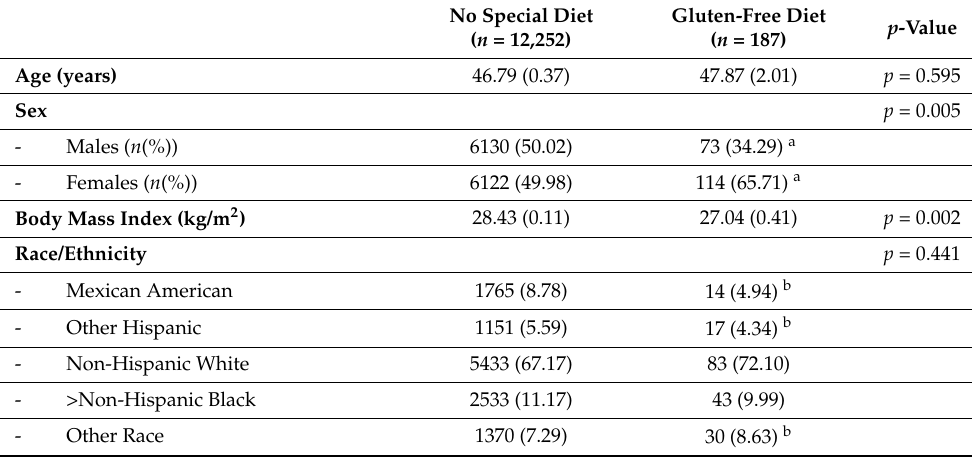
Figure 1. Participant inclusion flow chart. Table 2. Sample characteristics: demographic and anthropometric